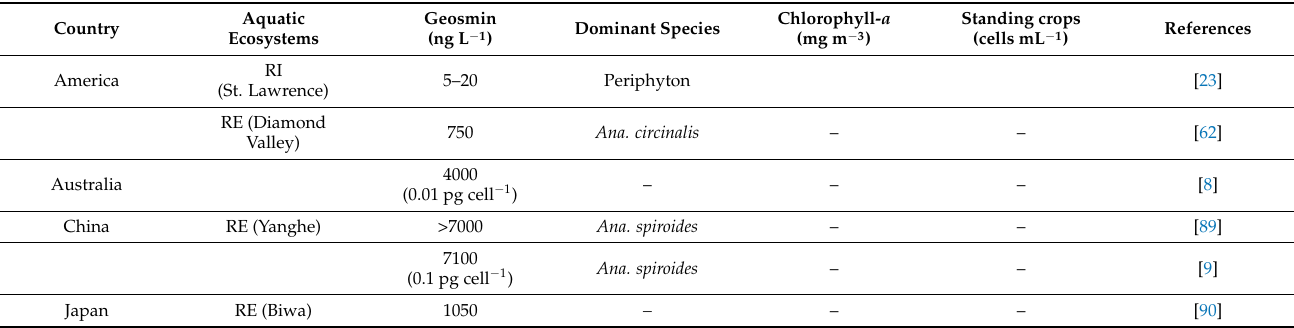
Table A1. Comparison of geosmin distribution with the occurrence of bloom-forming cyanobacteria in different aquatic